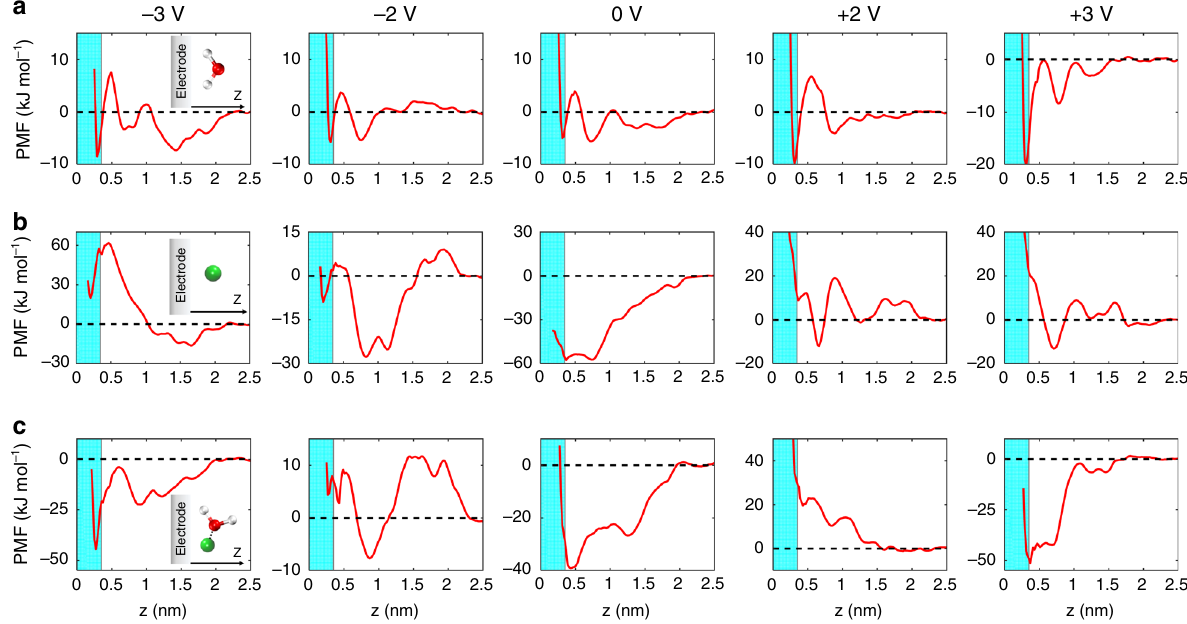
Fig. 4 Tendency for electrosorption of water, Li + and Li + -bound water at electrodes. a – c The potential of mean force (PMF) of water ( a ), Li + ( b ), and Li + -bound water ( c ) in 1-methyl-1-propylpyrrolidinium bis(tri fl uoromethylsulfonyl)imide ([Pyr 13 ][TFSI]) as a function of distance from the electrode. The cyan shaded region ( z < 0.35 nm) is considered as the interfacial